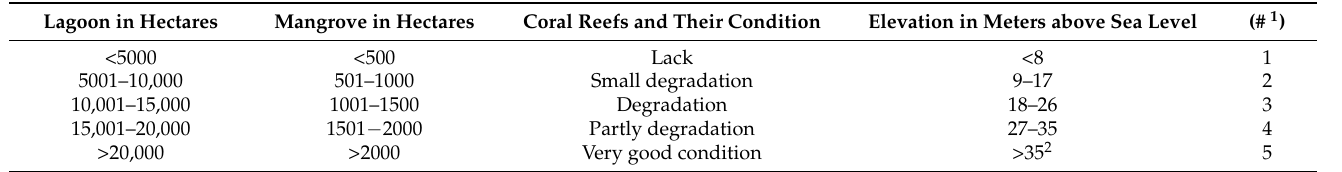
Table 2. Classification of natural elements. Sources: [67,68].